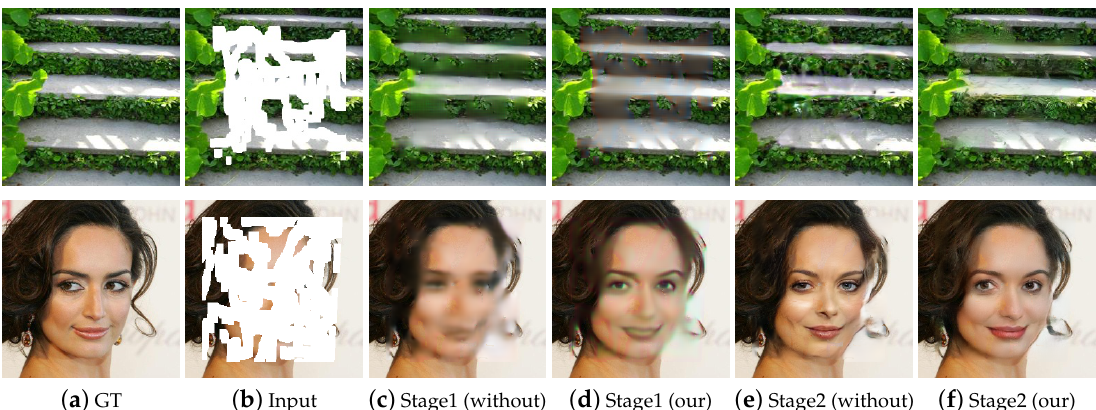
Figure 2. Comparison of inpainting results with or without our loss function at different